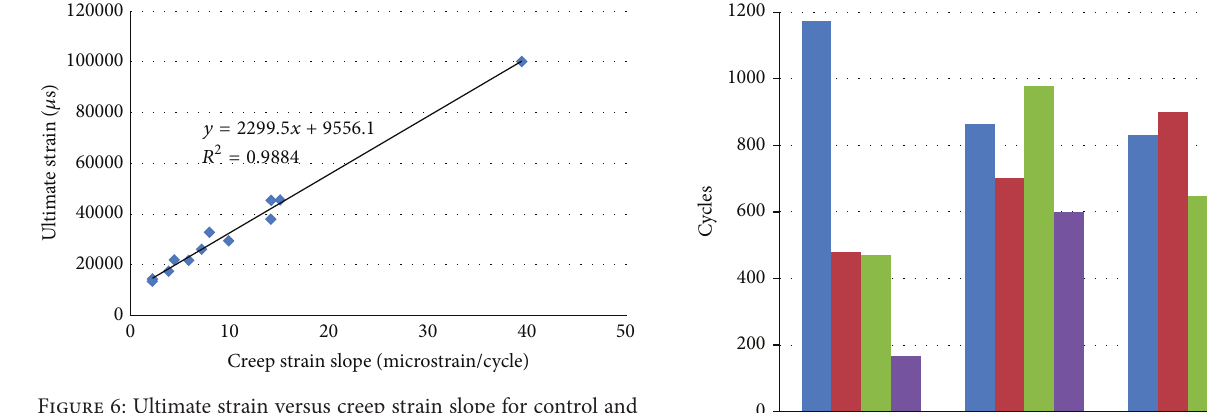
Figure 6: Ultimate strain versus creep strain slope for control and rubberized mixtures.